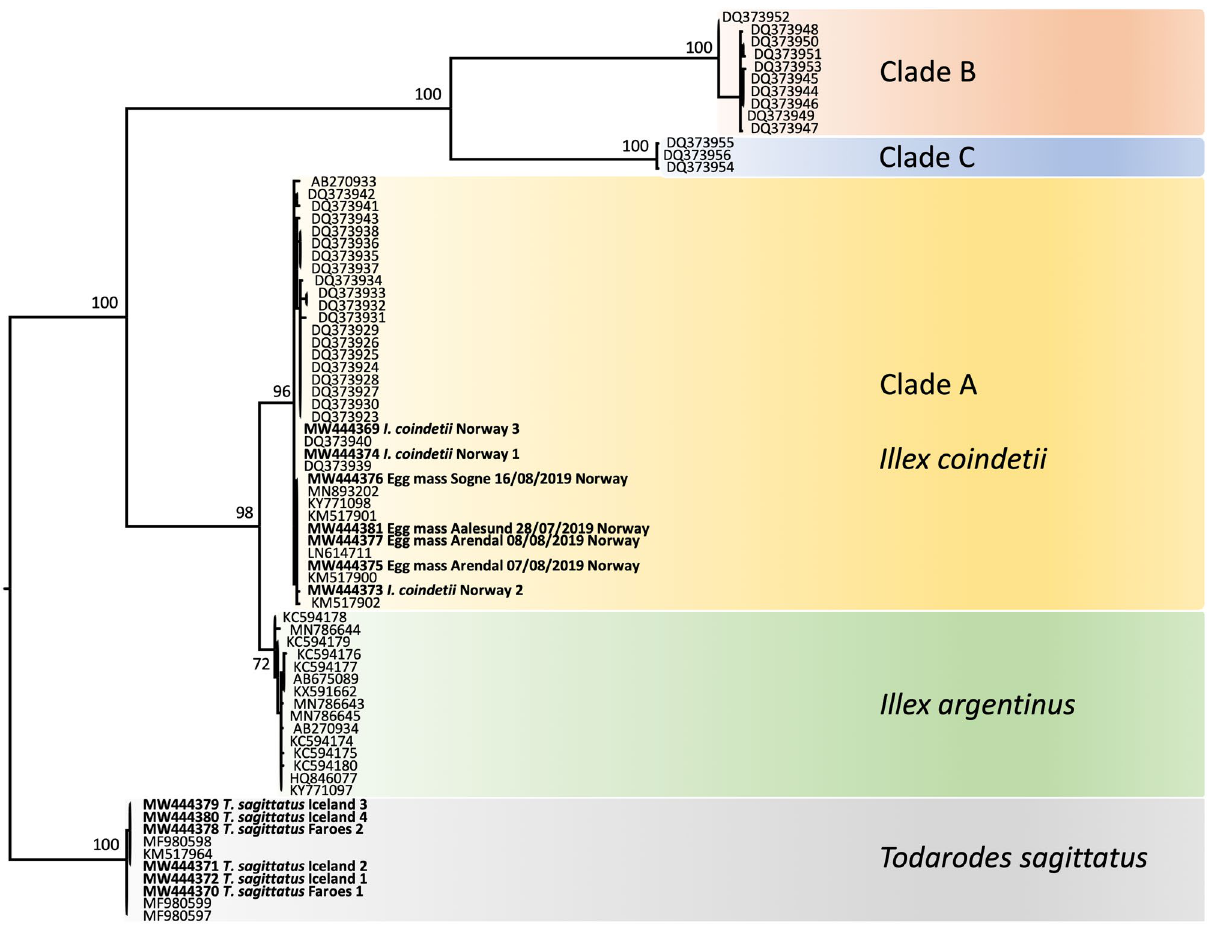
Figure 2. Maximum likelihood tree based on 624 base pairs of COI . Newly generated sequences shown in bold